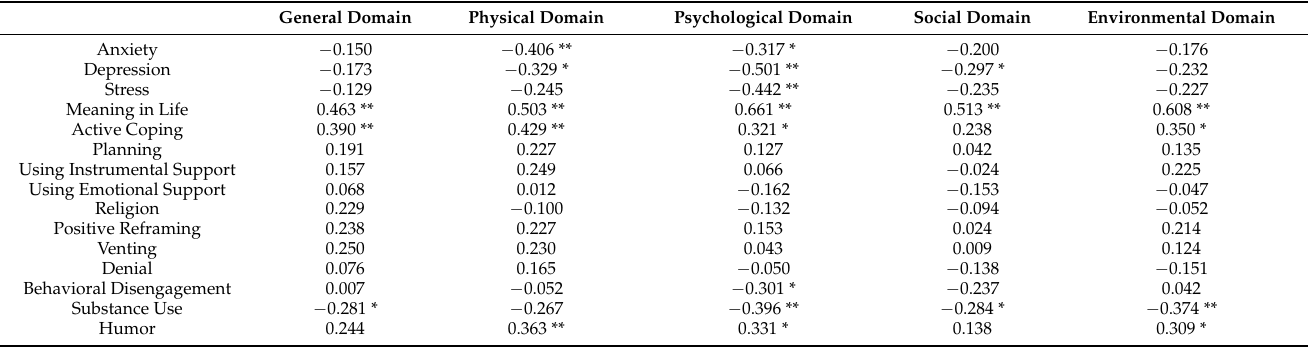
Table 3. Descriptive statistics for QoL domains (means, standard deviations, and range) and compar- ison of MS participants and healthy participants on QoL